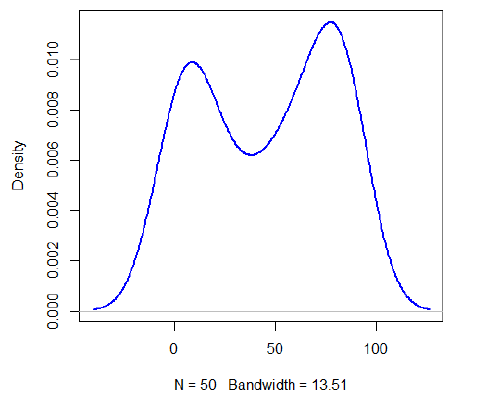
test transform (TTT), probability–probability (P–P) plot, and quantile–quantile (Q–Q) plot of the PZD for the failure times data.